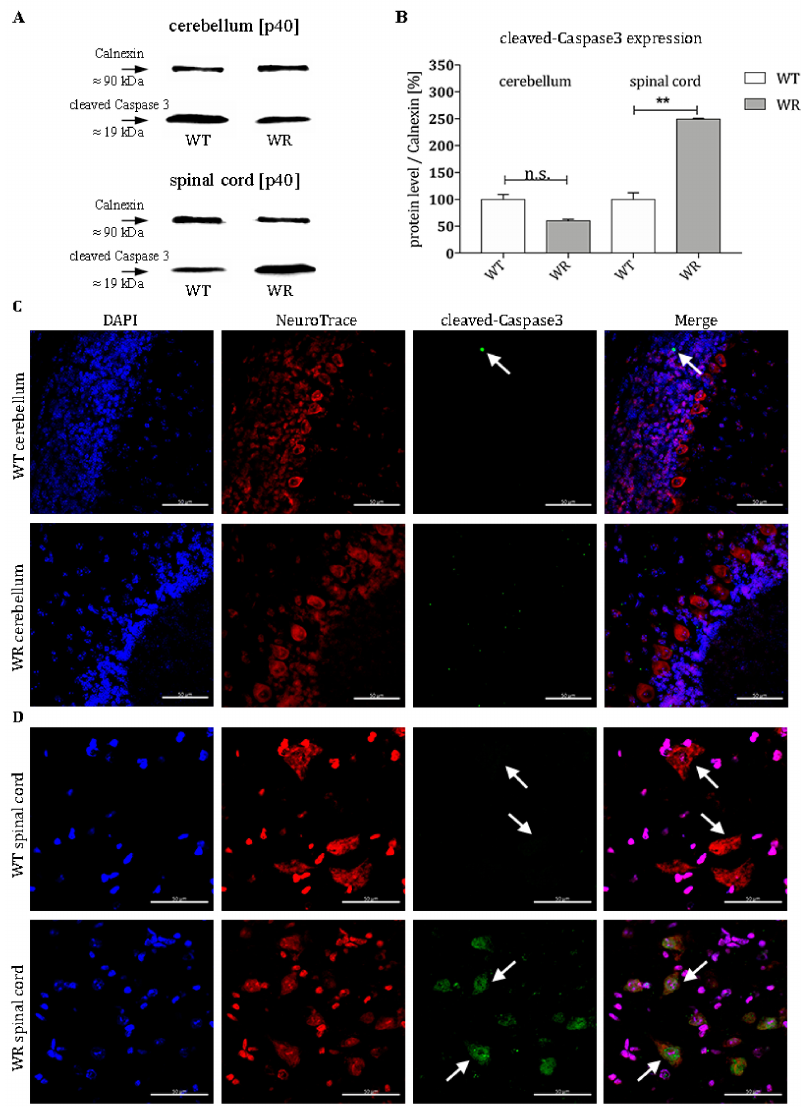
Figure 3. Alterations in cleaved-Caspase 3 expression in cerebellum and spinal cord of wildtype and wobbler mice. ( A ). Exemplary Western blot of cleaved-Caspase 3 in WT and WR cerebellum and cervical spinal cord at developmental stage p40. Calnexin was used as control protein. Intensity values of cleaved-Caspase 3 were normalized to calnexin and compared to WT tissue. ( B ). Quantitative analysis of cleaved-Caspase 3 protein expression level in the cerebellum and cervical spinal cord from stable symptomatic phase of WT and WR mice. No significant regulation was found in the cerebellum in wobbler mice, while there is a significant upregulation in the spinal cord. Data are provided as means ± SEM. Data were tested for significance using Student’s t-test. Significant di ff erences are indicated by n.s. = not significant, ** p < 0.01; n = 6. ( C ). Exemplary immunofluorescence staining of NeuroTrace, as Nissl marker (red), and cleaved-Caspase 3 (green). Nuclei were stained with DAPI (blue). Scattered staining of cleaved-Caspase 3 could be detected within the granular layer of the cerebellar slices of WT mice at p40 (white arrow). ( D ). Exemplary immunofluorescence staining of NeuroTrace, as Nissl marker (red), and cleaved-Caspase 3 (green). Nuclei were stained with DAPI (blue). Specific staining for cleaved-Caspase 3 was found to be located in NeuroTrace positive cells with a large cell body and nucleus, that can be assigned to be motor neuronal cells (white arrows). In WT cells the staining of cleaved-Caspase 3 was less marginal, than in WR cells. Pictures were taken using a confocal laser scanning microscope (LSM 800, Zeiss, Germany with a 40 × objective (PlanApo 40 × / 1.4 Oil DICII, Nikon instruments). Scale bar = 50 µ